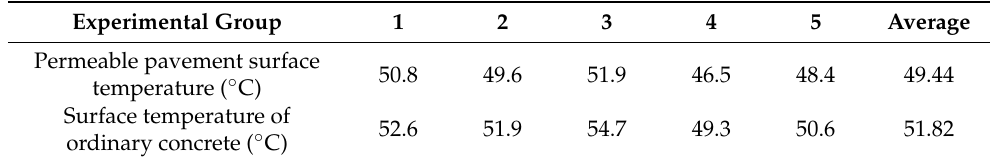
Table 6. Surface temperature records of permeable pavement at the case study Riverside Park, compared with the impermeable pavement at the nearby Sunken Island Park. Experimental